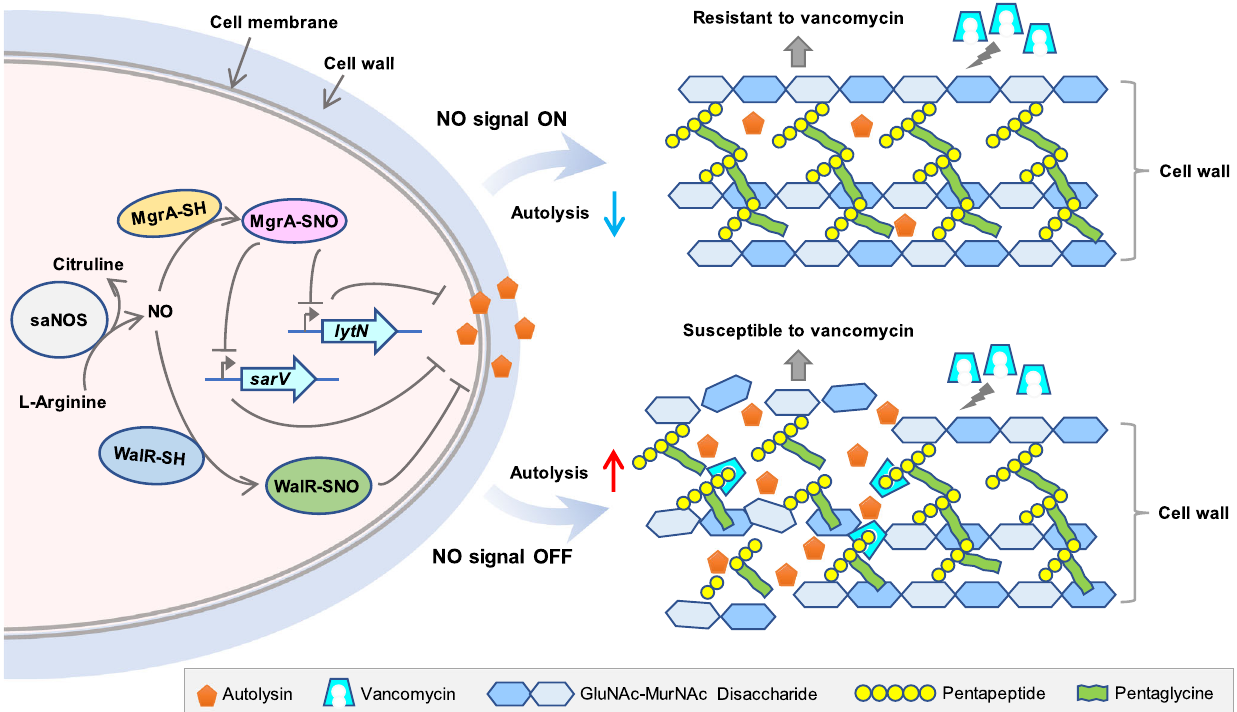
Fig. 7 | Mechanism of S-nitrosylation signal transduction to vancomycin resistance. S.aureus hasevolved saNOSto generateNO. WhentheNOsignalison, MgrAandWalRundergoS-nitrosylationonthecysteinethiol,therebyinitiatingthe transcriptionalrepressionsignalstothedownstreamgenessuchas lytN and sarV to inhibit autolysin expression, which leads to a thickened cell wall and increased resistance to vancomycin. When the NO signal is off, the autolysin production will